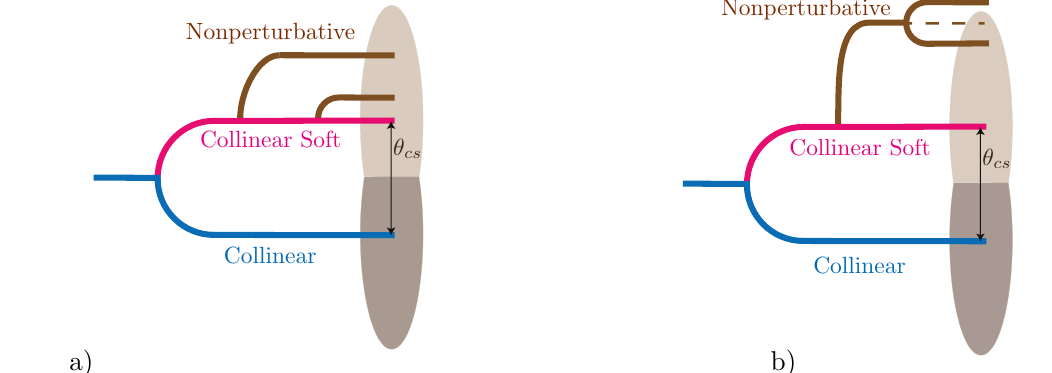
to act on NP subjets NP